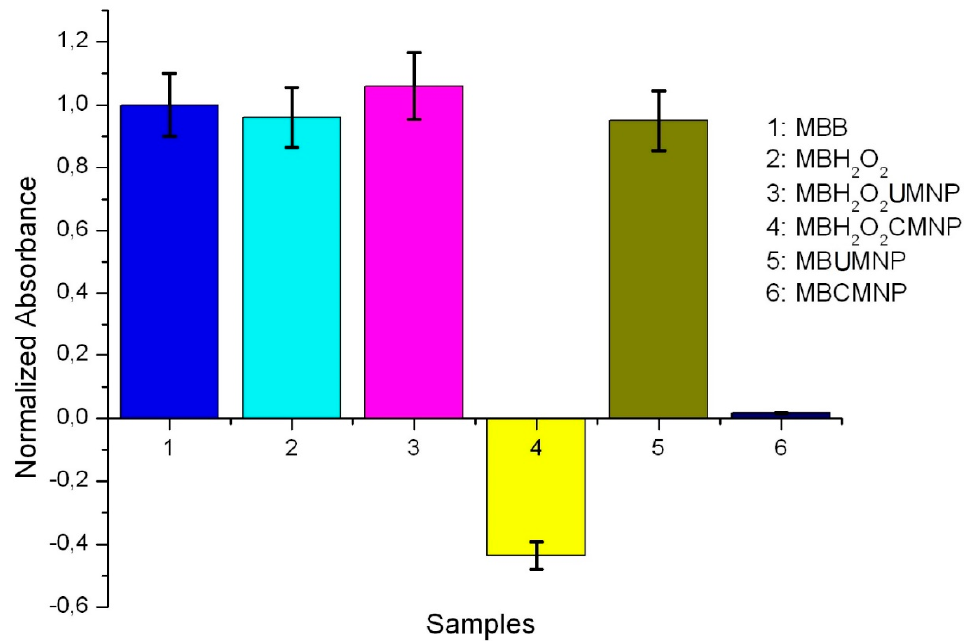
Figure 6. Bar plot representing the absorbance of the samples MBB, MB H 2 O 2 , MB H 2 O 2 UMNP, MB H 2 O 2 CMNP, MB UMNP, and MB CMNP.